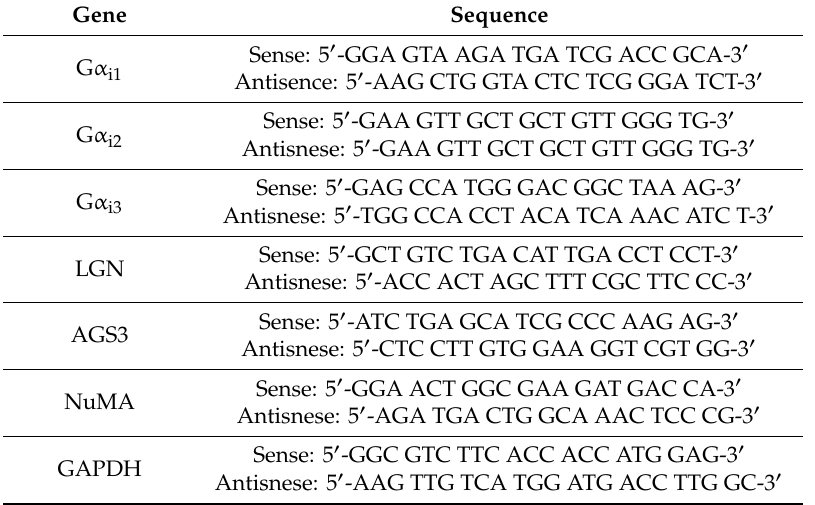
Table 1. Primer sequences used in detecting mRNA expression of corresponding genes by RT-PCR.